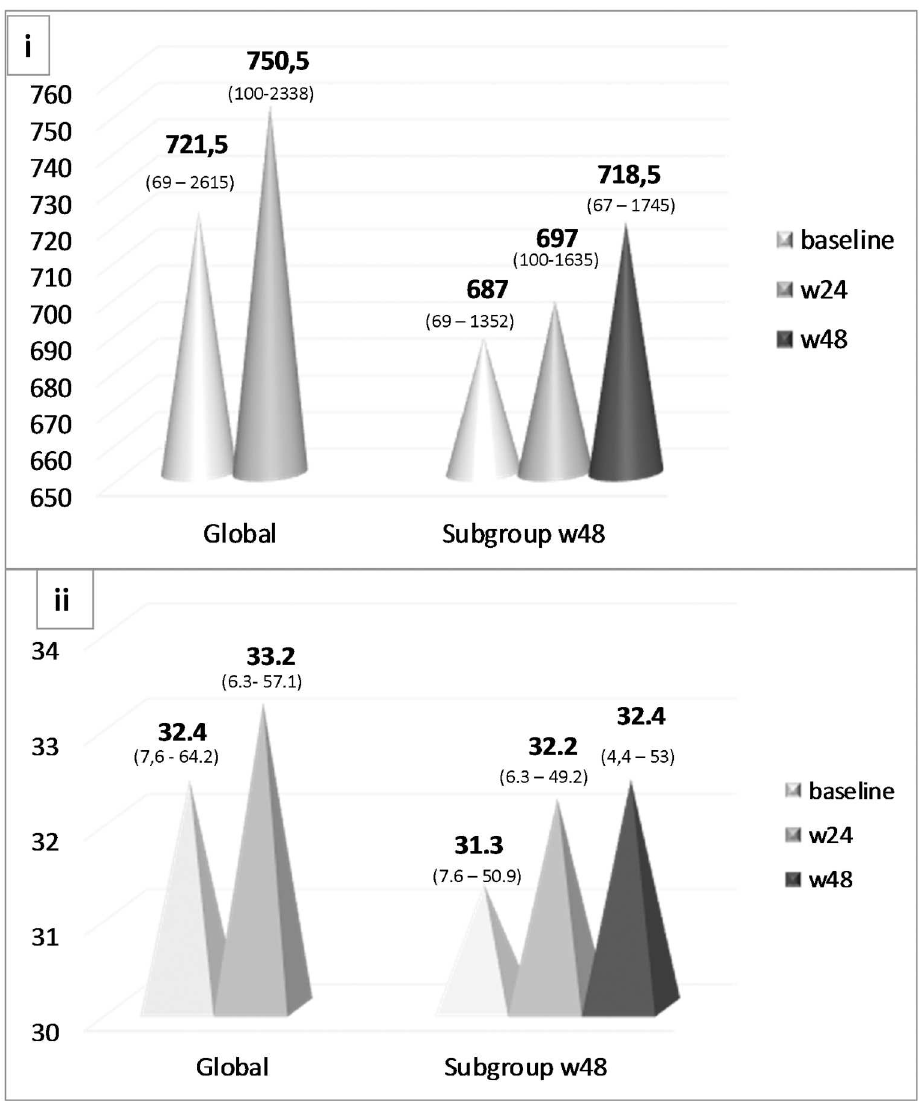
Fig 3. Absolute CD4+ T-cell count (i) and proportion of CD4+ T-cells (ii) in the global population and in the subgroup that reached week 48, median